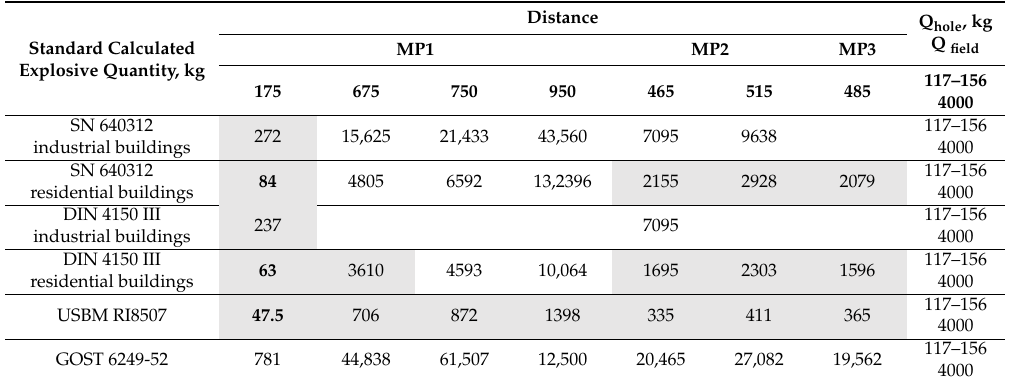
From Table 3 shaded and bold values represent critical